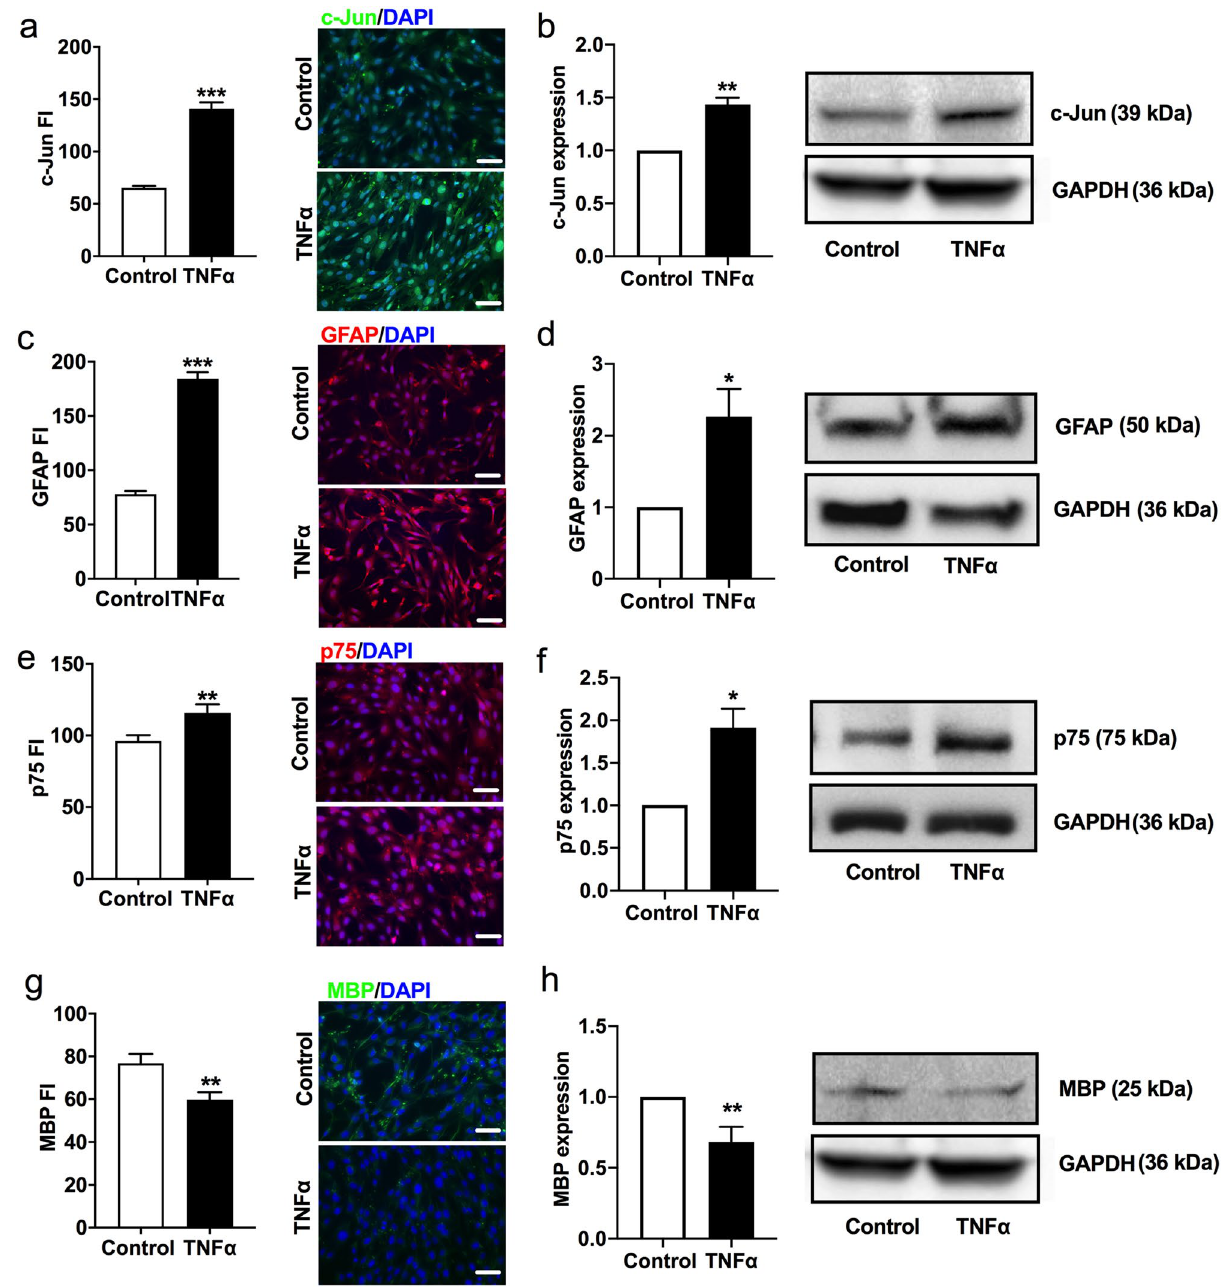
Figure 5. The effect TNFα on the expression of Schwann cell activation markers in vitro. TNFα treatment increased c-Jun ( a , b ), GFAP ( c , d ), and p75 ( e – f ) immunofluorescence intensity and protein expression in cultured Schwann cells compared to the DMEM control. TNFα treatment decreased MBP immunofluorescence intensity and protein expression in cultured Schwann cells compared to the DMEM control ( g – h ). Full- length gel blots were provided in the Supplemental Fig. S1 online. Scale bar: 100 μm. Student’s t-test. * P < 0.05; ** P < 0.01; *** P <